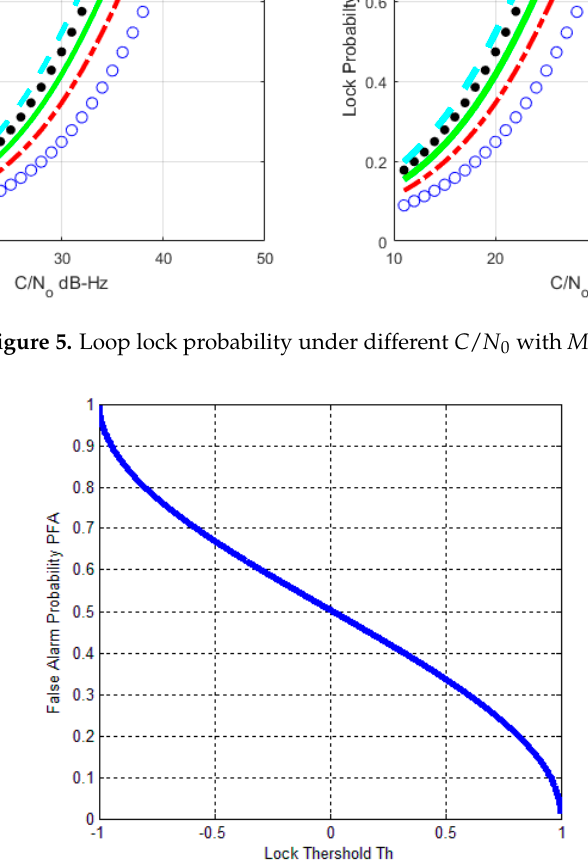
Figure 6. Relation between FLD false alarm probability and threshold ( Th ).